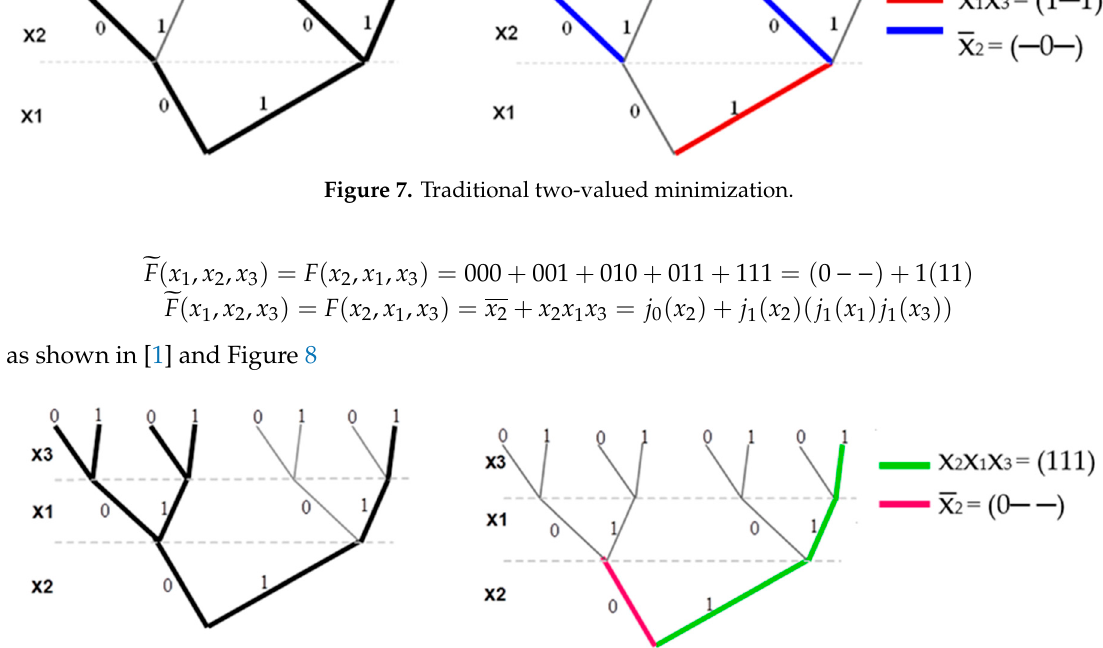
Figure 8. Di ff erent version of the equivalent continual two-valued decision Figure 8. Different version of the equivalent continual two-valued decision tress. Figure 8. Different version of the equivalent continual two-valued decision tress. Figure 8. Different version of the equivalent continual two-valued decision tress.